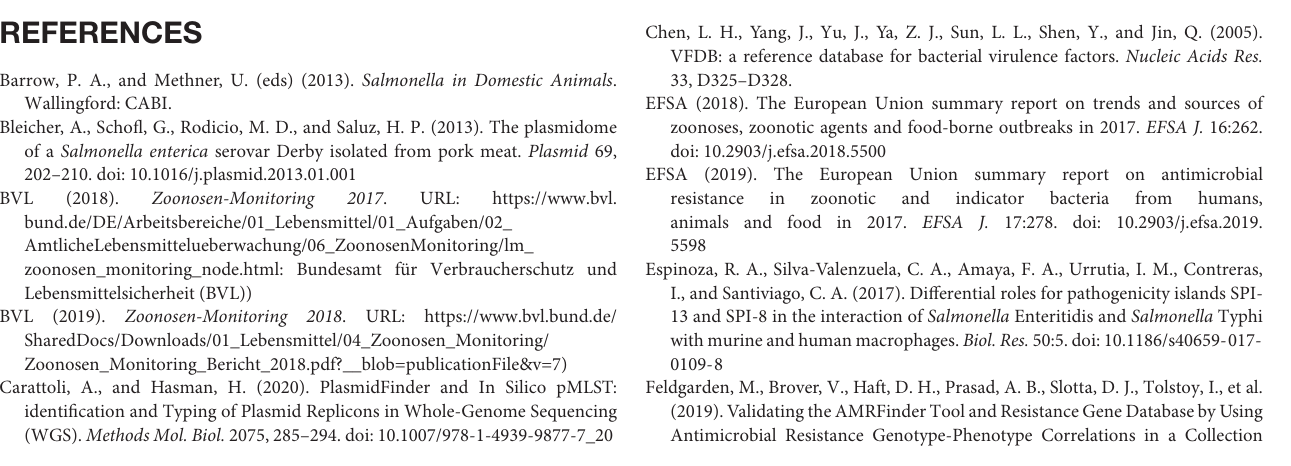
Supplementary Table 5 | Virulence genes detected in both collections. Supplementary Table 6 | Single nucleotide polymorphisms (SNPs) analysis. Supplementary Table 7 | Genome accession and metadata for our sequence